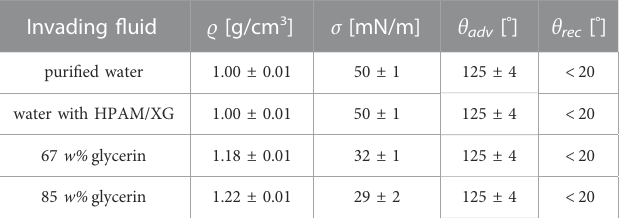
TABLE2Density(  )measuredbyapycnometer(Blaubrand,BrandGmbH),aswell as interfacial tension ( σ ) determined by pendant drop method, and advancing ( θ adv ) and receding contact angle ( θ rec ) of the utilized combinations of invading fl uids and dodecane determined by sessile drop needle-in method using the contact angle measurement device (OCA 25, DataPhysics). It should be noted that the addition of HPAM, respectively Xanthan gum (XG) to water did neither alter the interfacial tension nor the